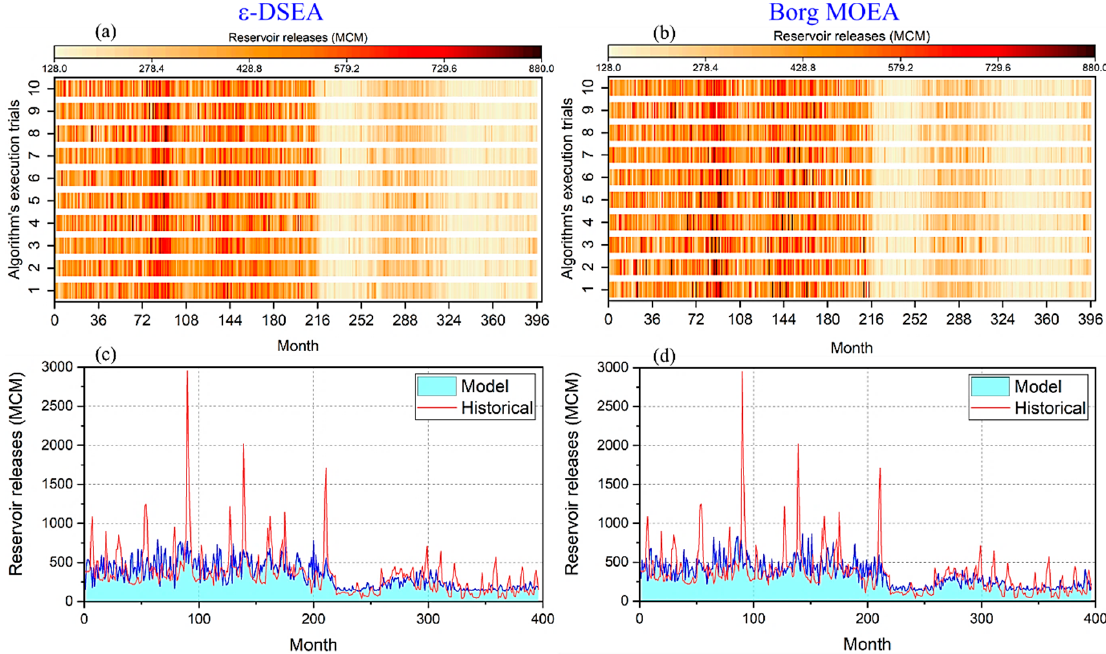
1 Surface area of reservoir in km 2 ; 2 Head of water in m.a.s.l; 3 Hydropower generation in MW; 4 Reservoir storage in m 3 × 10 6 ); 5 Reservoir releases in m 3 / month × 10 6 ; 6 Gross sum units of: Power in GW; Storage in m 3 × 10 9 ); Releases in m 3 / month × 10 9 . 7 St. for Standard Deviation.